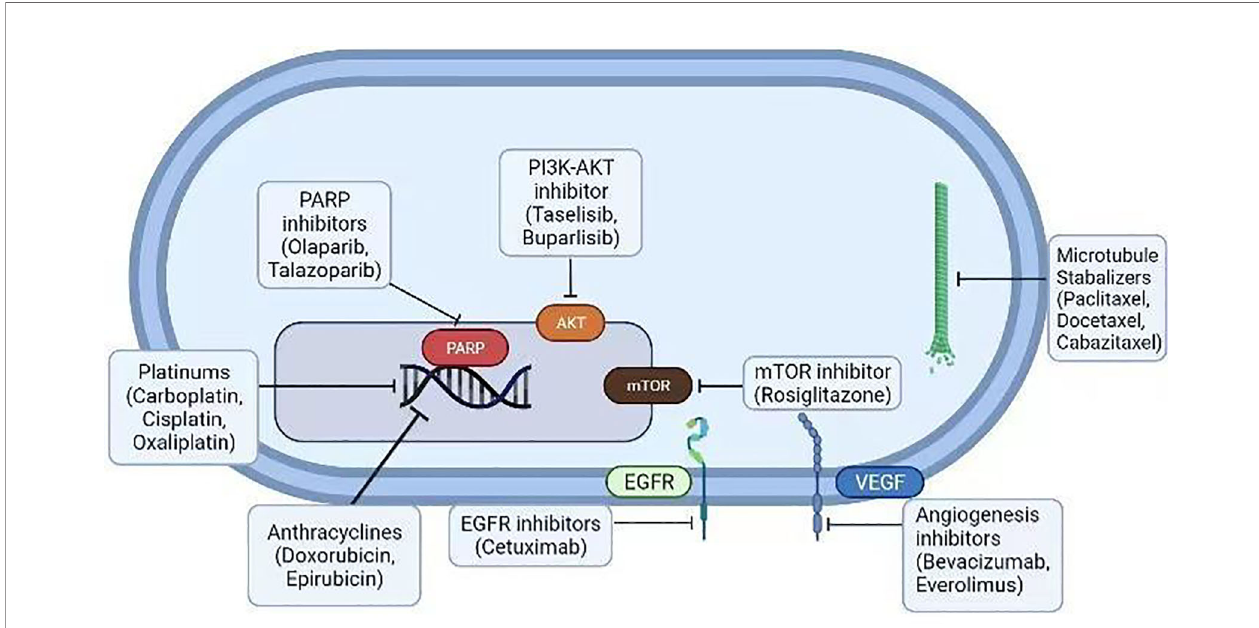
FIGURE 3 | Various conventional therapeutic agents (platinum drugs, anthracyclines, EGFR blockers, mTOR blockers, angiogenesis inhibitors, microtubule stabilizers, and PARP and PI3K-Akt inhibitors) were examined against the BCs. Many of them are FDA-approved drugs for BC